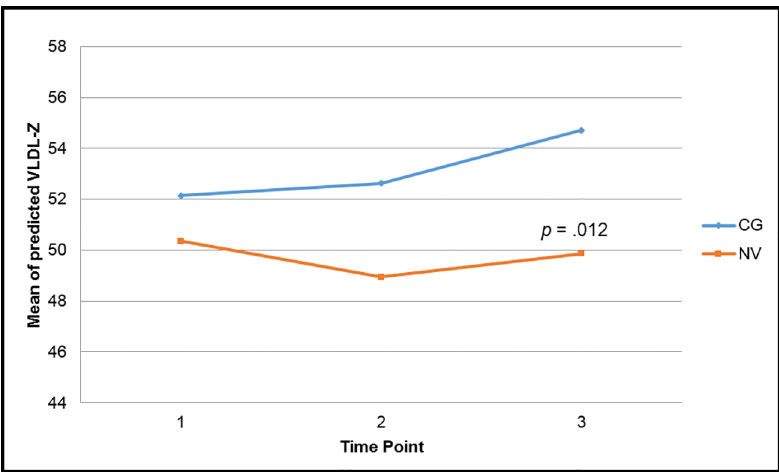
Fig 3. Predicted total VLDL-Z particle size over time based on caregiverstatus. Contrast tests showed significantdifferences betweentime-point 3 and time-point 1 ( p = .0152) and betweentime-point3 and time- point 2 ( p = .0481) for caregivergroup only. CG caregiver, NV normalvolunteer.